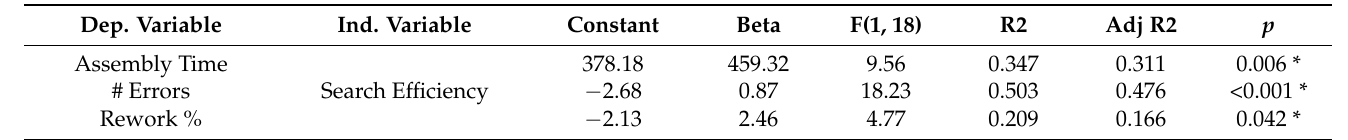
Table 12. Regression—search efficiency (average convex hull coverage) by pipefitter assembly performance (assembly time (s), number of errors, rework (%)). Dep.